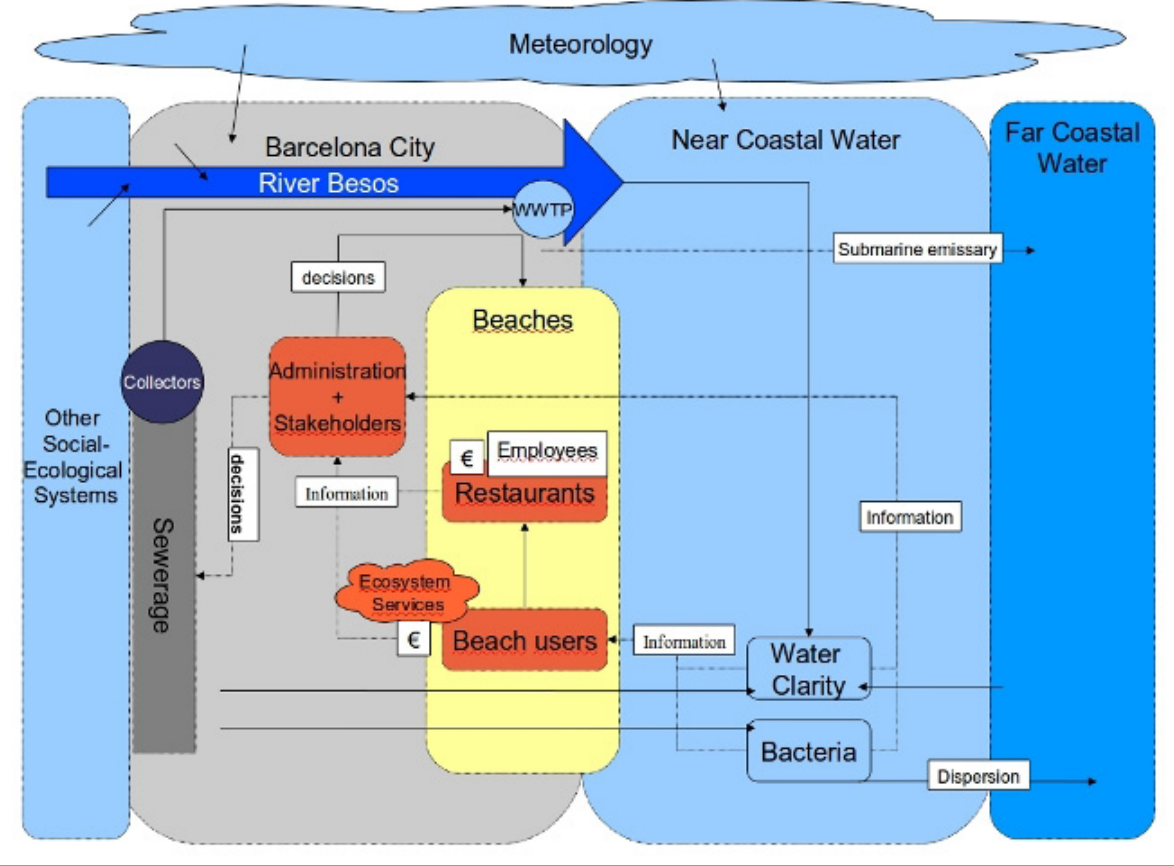
Fig. 2 . Conceptual model of the system. The model was refined from the first meeting to the third, and includes those aspects that arose during the whole process of modeling. The format was suggested by the Catalan Water Agency during the second meeting. A simple PowerPoint diagram was chosen as a familiar way of visualizing information for all the